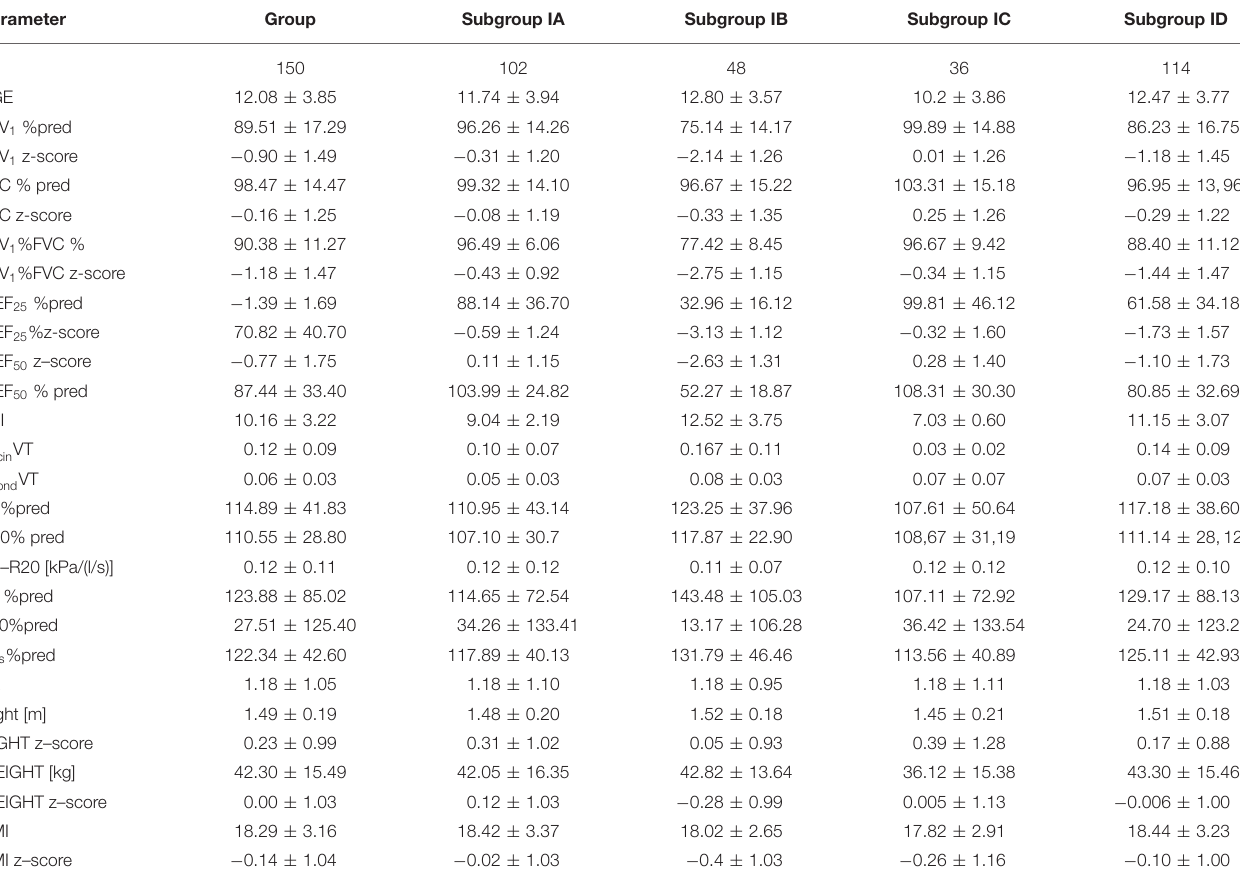
TABLE 1 | CF patients study group and subgroups characteristics: subgroup IA without spirometric features of obturation, IB with obturation features, IC [LCI ( ≤ 7.91)] and ID (LCI ( > 7.91)].